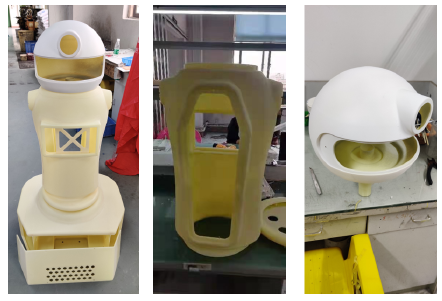
Figure 26. Hardware setup of the air-conditioner